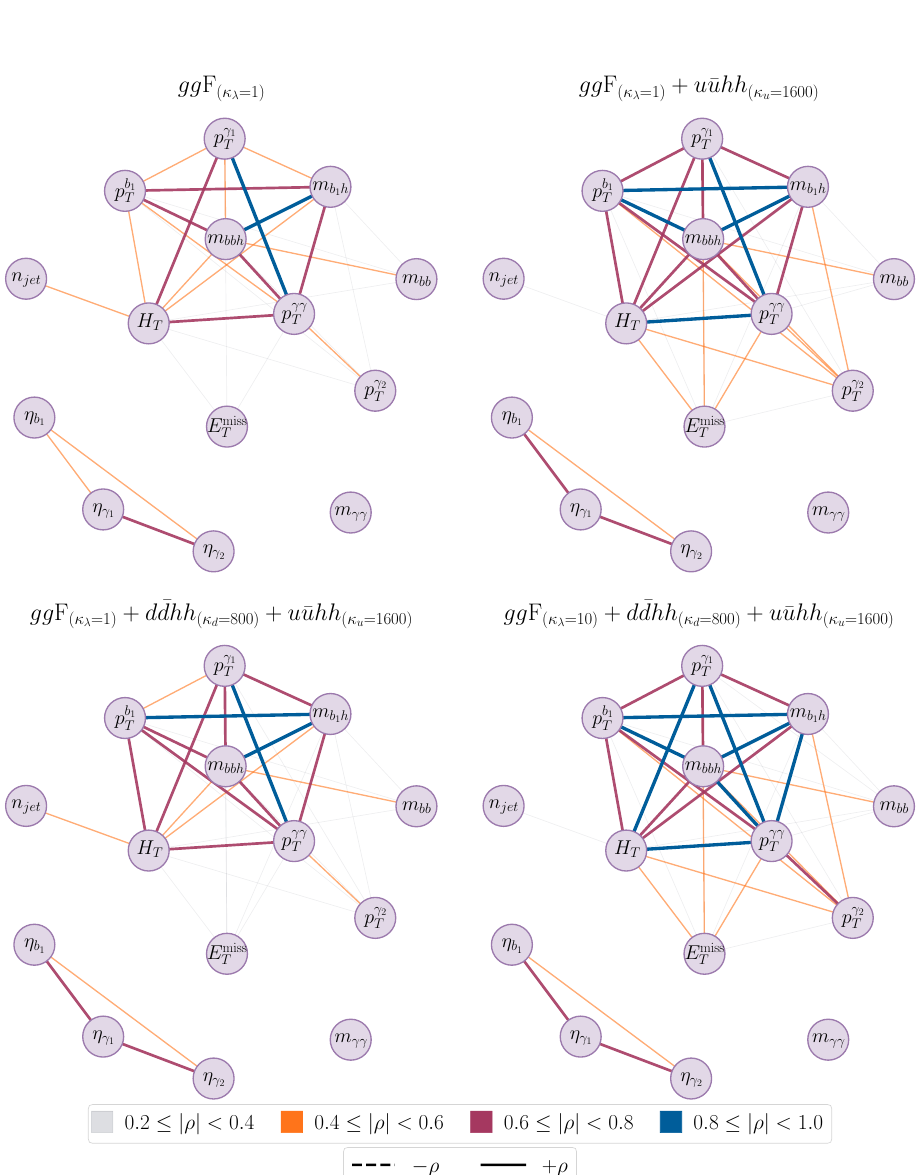
Figure 9 . Network diagrams visualization of correlations ( ρ ) amongst the kinematic variables used in the analysis. Top left: only the gluon-gluon fusion channel. Top right: the gg F channel along with the u ¯ uhh channel with κ = 1600 . Bottom right: the d ¯ dhh channel with κ u the channels in the top right panel. Bottom left: the same channels as in the bottom right panel but with κ = 10 λ